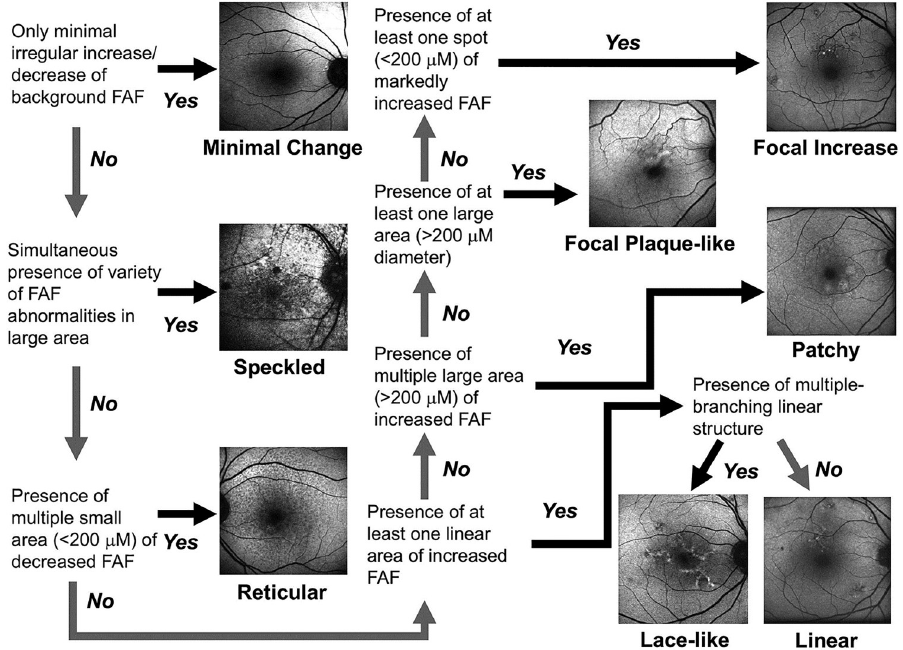
Fig 1. Flow chart for classifying abnormal